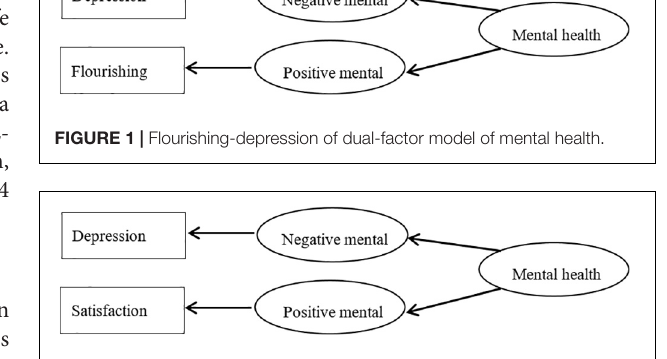
FIGURE 2 | Satisfaction-depression of dual-factor model of mental